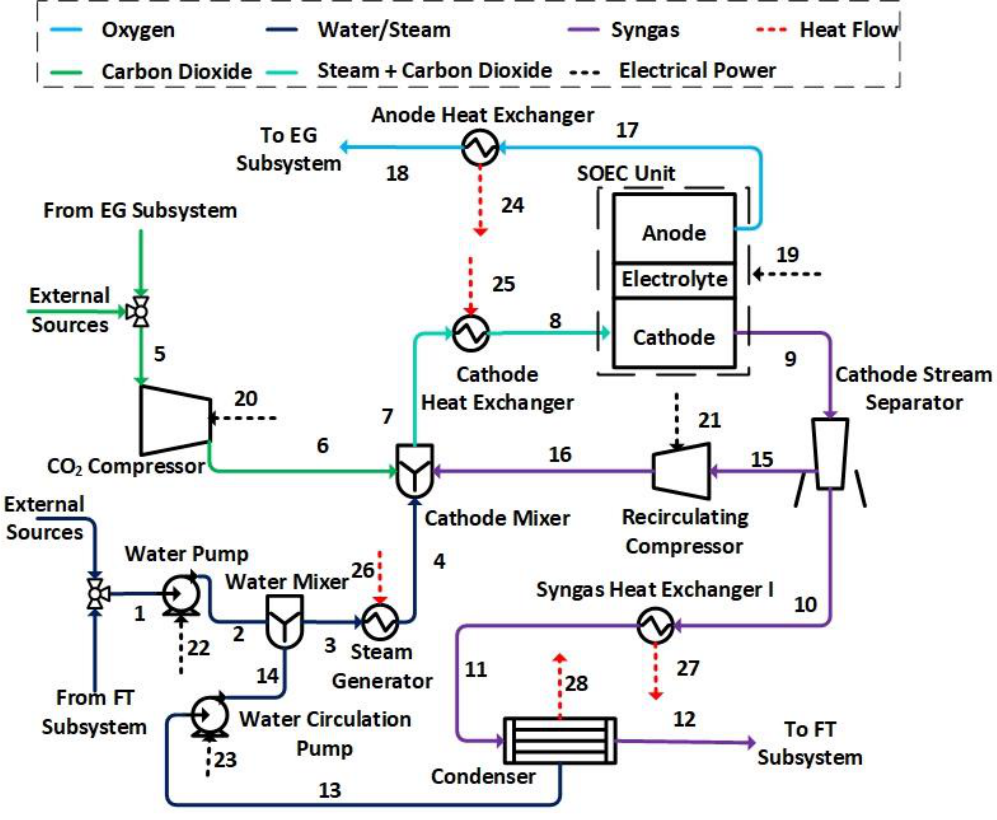
Figure 2. Schematic of the SOEC subsystem.